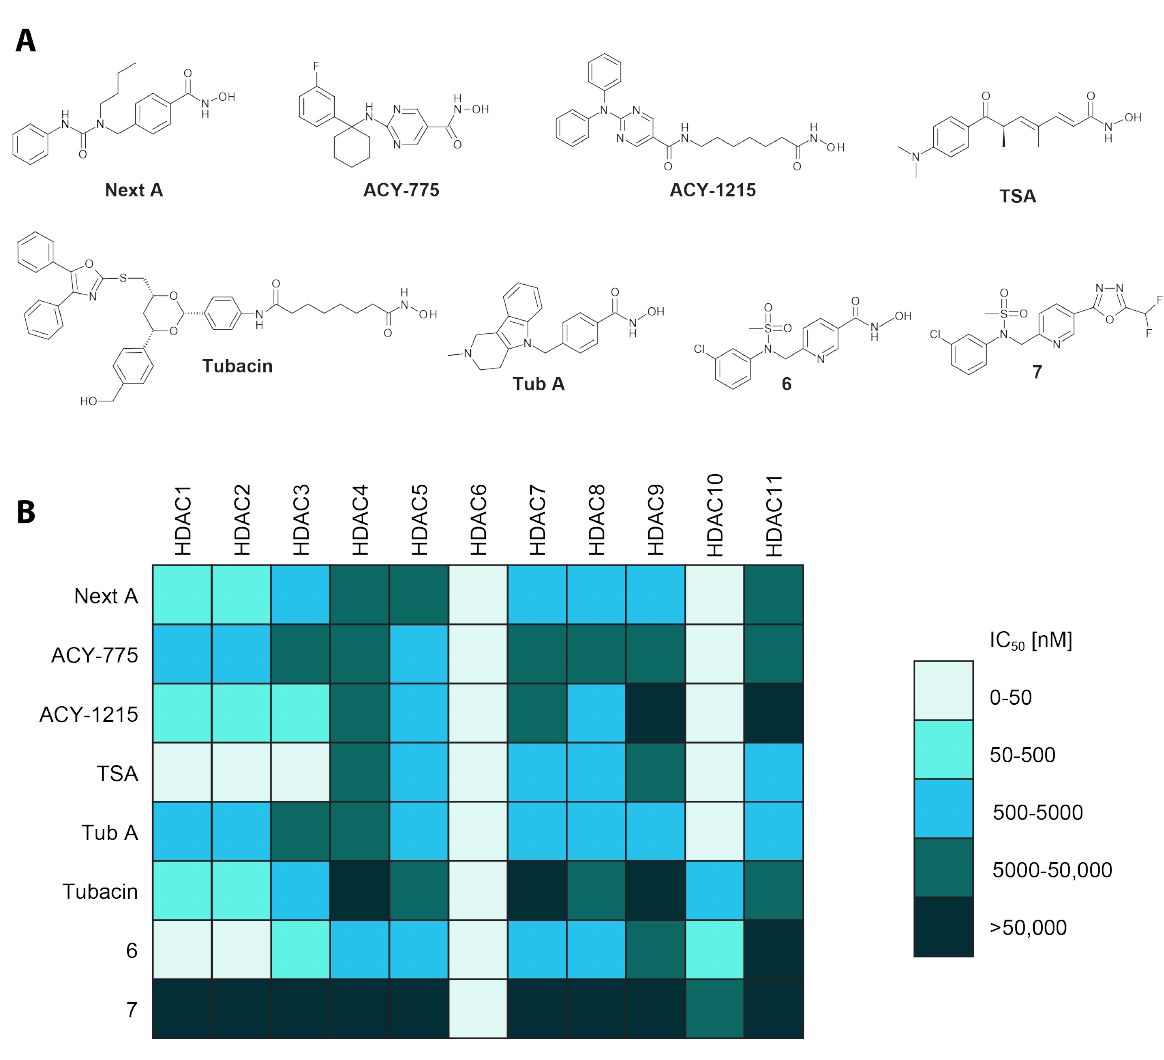
Figure 1. In vitro profiling of HDAC6is. Panel ( A ) Formulas of compounds tested in this study. Five currently used inhibitors are considered HDAC6-specific, TSA as a control pan-specific HDAC inhibitor, and compound 6 synthesized specifically for this comparison. Compound 7 is an analog of 6 having an oxadiazole zinc-binding group (ZBG), as compared to remaining inhibitors that utilize a hydroxamate ZBG. Panel ( B ) Purified recombinant human HDACs were used to determine the potency of studied inhibitors in activity assays in vitro. IC 50 values were calculated from fitted data and plotted in the color-coded table. For exact underlying values, refer to Supplementary Materials Table S2. While hydroxamate-based compounds show off-target inhibition (primarily against HDAC10), the oxadiazole-based compound 7 is highly selective for HDAC6.